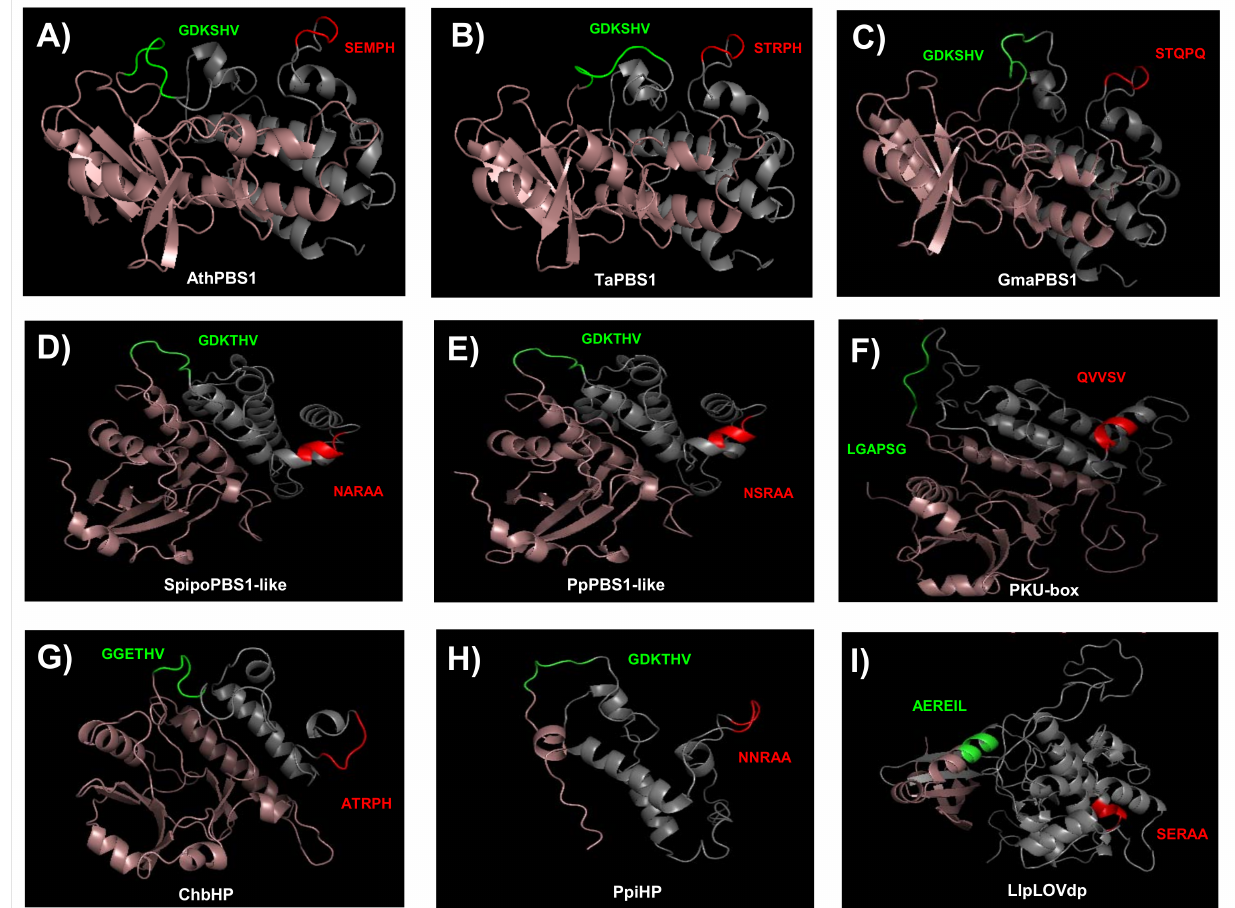
Figure 10. Predicted structures of PBS1 from several plant species. Swiss Predictive structures for PBS1 orthologs were generated with Swissmodel. ( A ) AthPBS1 from Arabidopsis (amino acid residues 71 to 366); ( B ) TaPBS1 from T. aestivum (residues 89 to 386); ( C ) GmaPBS1 from G. max (residues 84 to 381); ( D ) SpipoPBS1-like from S. polyrhiza (residues 72 to 356); ( E ) PpPBS1-like from P. patens (residues 71 to 361); ( F ) CrePKU from C. reinhardtii (residues 474 to 786); ( G ) ChbHP from Ch. braunii (residues 16 to 249); ( H ) PpiHP from P. pinaster (residues 2 to 123); ( I ) LlpLOVdp from L. linearis (residues 346 to 689). Models for AthPBS1, TaPBS1, GmaPBS1, and ChbHP were based on the BIK1 structural model (SMTl ID: 5tos.1). Models for CrePKU and PpiHP were based on the PK (SMTI ID: 6j5t.1). Models for SpipoPBS1, PpPBS1-like, and LlpLOVdp were based on BAK1 (SMTI ID: 3tl8.1), BR1 (SMTI ID: 5lpz.1), and BAC (SMTI ID:6npz.1. A). Cleavage site (GDKSHV) and putative cleavage sites are represented in green. The RPS5 recognition motif (SEMPH) and putative RPS5 recognition motifs are represented in red. Structure from the N-end to the putative cleavage site motif is shown in pink. Structure from putative RPS5 recognition motifs to the C-end is represented in gray. BIK1, Botrytis-induced kinase 1; BAK1, BRASSINOSTEROID INSENSITIVE 1-associated receptor kinase 1; BR1, Protein BRASSINOSTEROID INSENSITIVE 1; PK, Protein kinase superfamily protein; BAC, RAC-alpha serine/threonine-protein kinase. SMTI ID: Swiss-Model accession